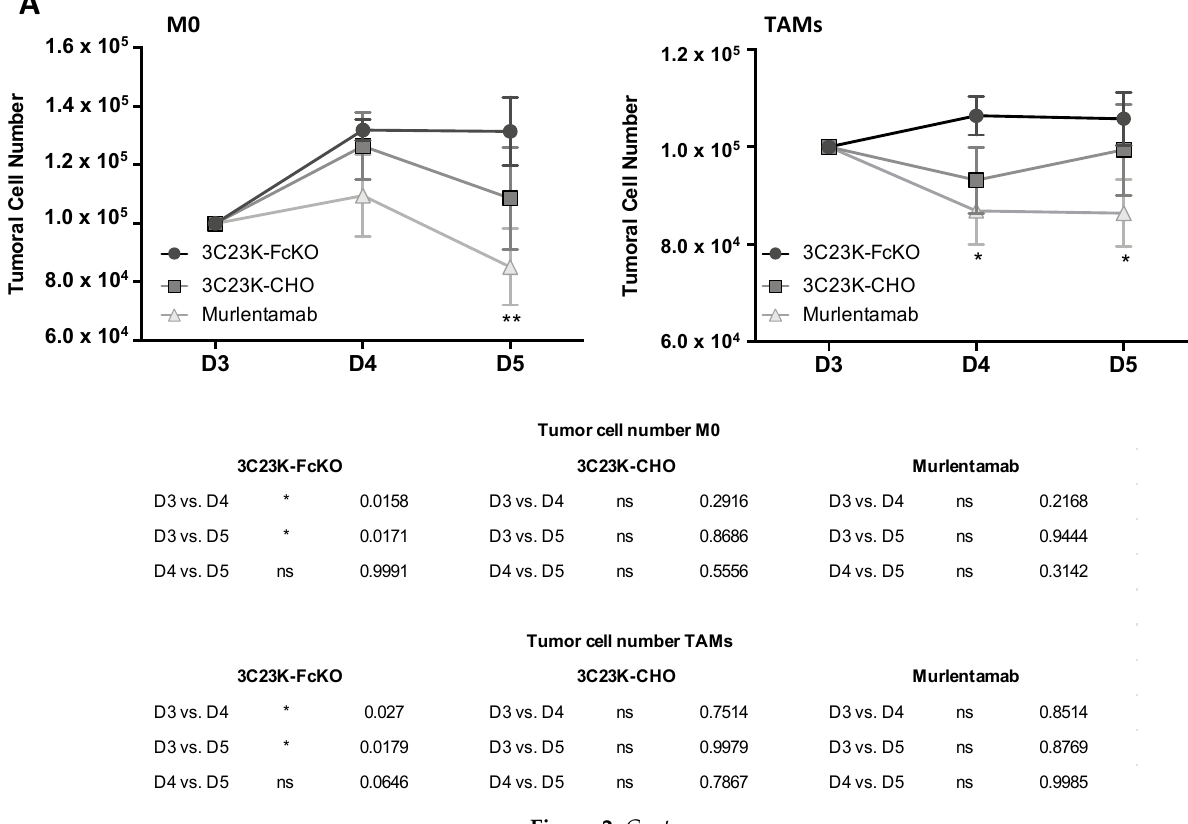
Figure 2. Murlentamab opsonization of SKOV3-R2 + increases macrophage anti-tumoral activity and antibody-dependent cell-mediated cytotoxicity (ADCC) killing. SKOV3-R2 + ovarian tumor cells were labeled with different 3C23K antibodies (3C23K-FcKO control, 3C23K-CHO normally fucosylated or murlentamab the low fucosylated form) and cultured in the presence of human monocyte-derived macrophages from healthy donors unstimulated (M0) or stimulated with M-CSF and IL-10 (tumor-associated macrophages (TAMs)). ( A ) Opsonized - SKOV3-R2 + cell number was determined by flow cy- tometry after one and two days of co-culture with M0 or TAMs. * p < 0.05; ** p < 0.01 compared 3C23K-FcKO vs. murlentamab at a given time ( B ) ADCC was performed after 4 h of co-culture between SKOV3-R2 + cells and M0 or TAMs. Data shown (mean ± SEM) are the results from three different experiments (performed with three different healthy do- nors). * p < 0.05; **** p < 0.0001. p values were determined using one-way ANOVA analysis followed by Tukey’s multiple comparisons test.